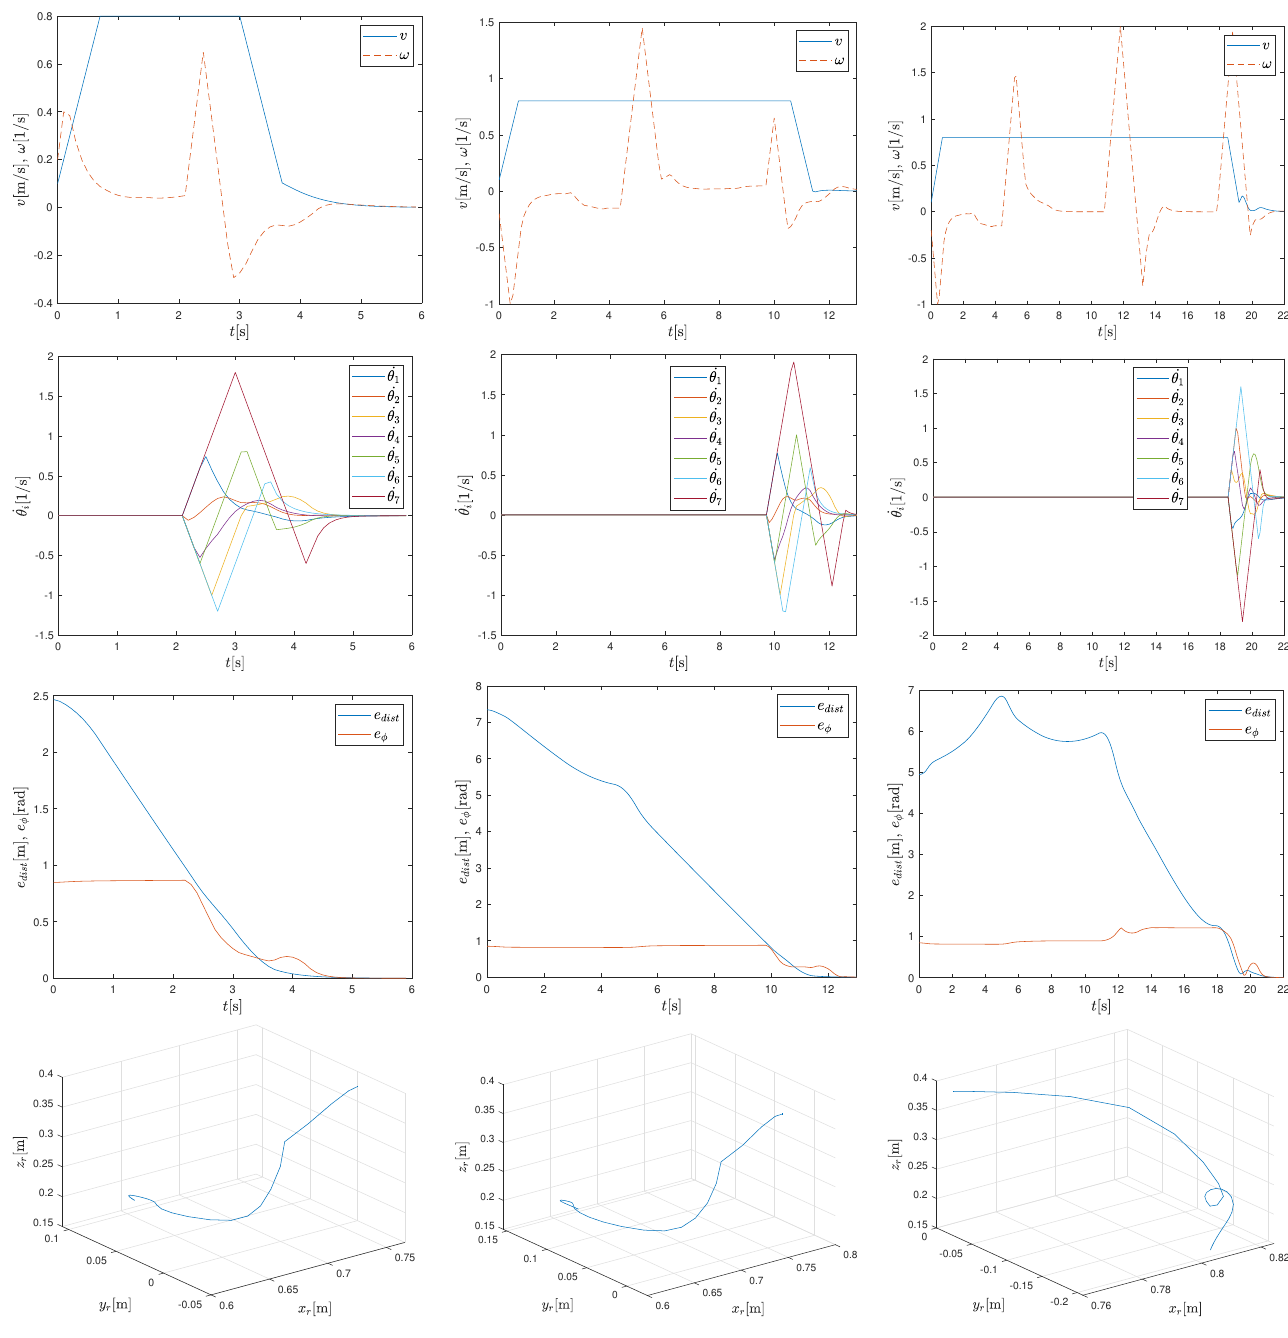
Figure 9. Velocities of the base (first row), velocities of the arm joints (second row), distance error and norm of the orientation error to the target pose (third row), and relative position of the end effector with respect to the mobile base (fourth row) for the scenarios in Figure